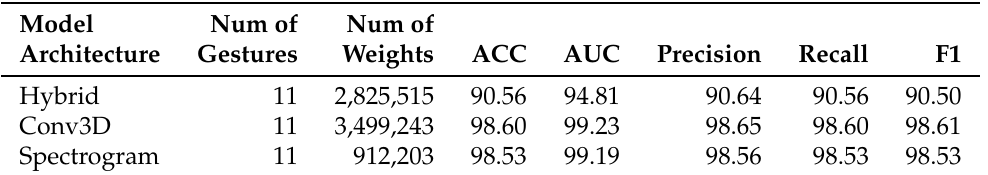
Table 1. Evaluation of three model architectures for mid-air gesture detection. The classifiers were trained to recognise 11 mid-air gestures from publicly available gesture set [48].